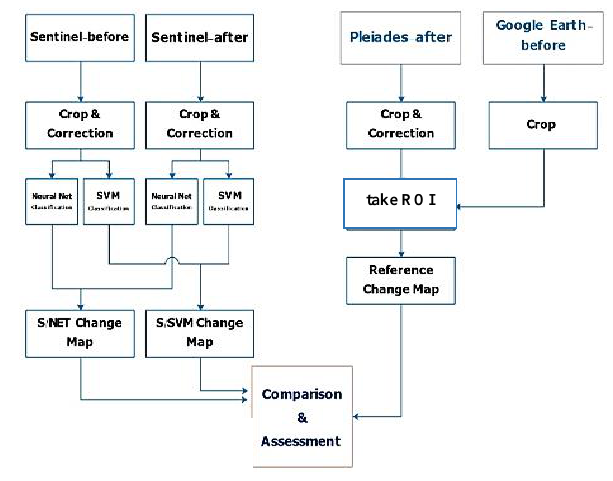
Figure 2. Proposed